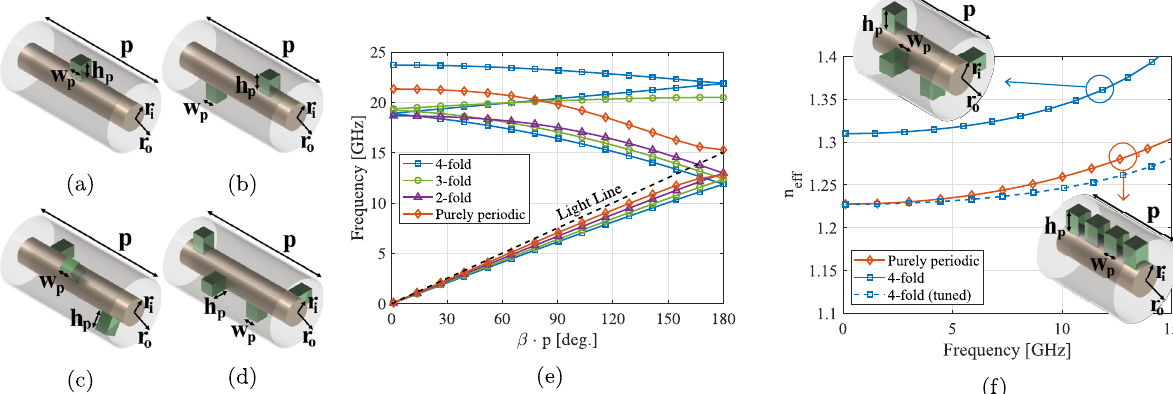
Fig. 1. Simulated perfect twist-symmetric structures with pin-type deformations. Studied structures: (a) purely periodic, (b) 2-fold, (c) 3-fold, and (d) 4-fold. (e) Dispersion diagram using the dimensions: h p =1.2 mm, w p =1 mm, r i =1 mm, r o =2.5 mm, and p =10 mm; (f) Effective refractive index comparison of the purely periodic and 4-fold twist-symmetric structures with dimensions: h p =1.2 mm (tuned: h p =1.075 mm), w p = 1 mm, r i = 1 mm, r o = 2.5 mm, and p